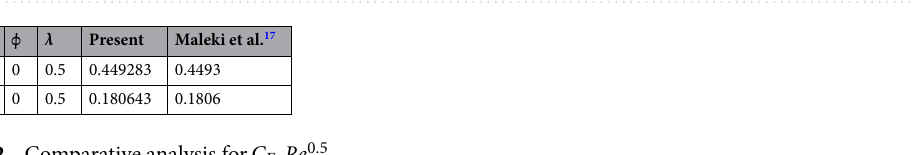
Table 2. Comparative analysis for C Fx Re 0.5 x